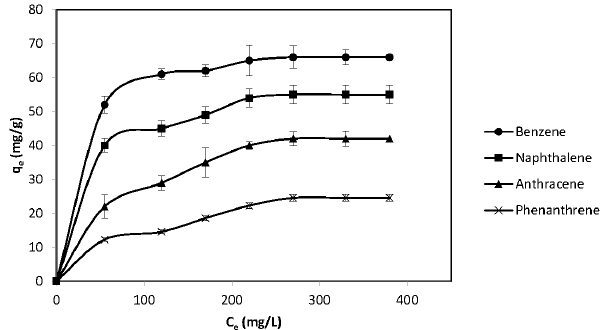
Figure 7. The isothermal adsorption of benzene, naphthalene, anthracene, and phenanthrene by wood-based powdered activated carbon (PAC) (pH = 7 at room temperature).